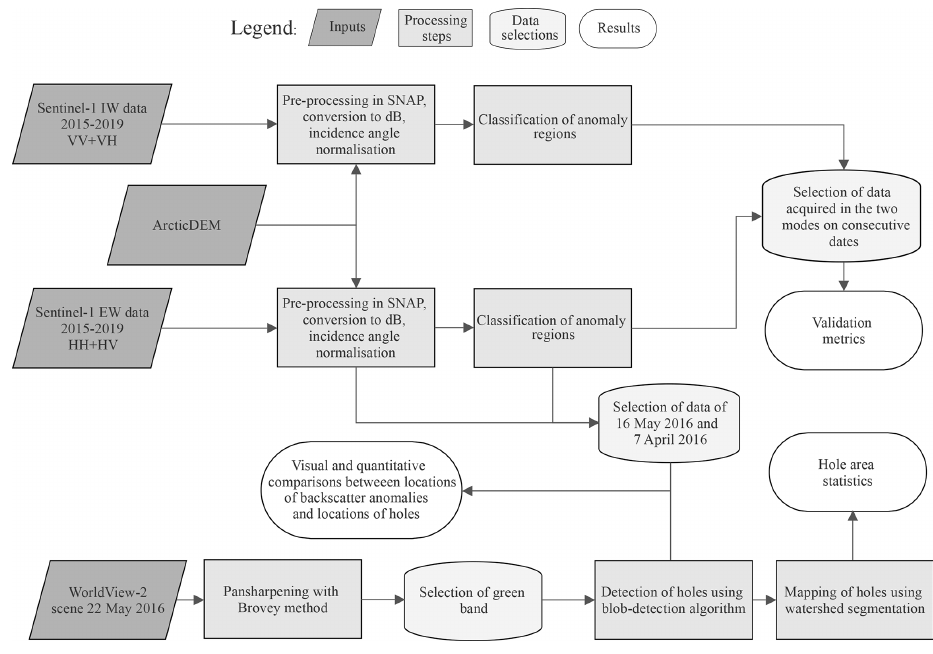
Figure 3. Workflow of main processing, selection and analysis steps associated with Sentinel-1 and WorldView-2 imagery in this study.